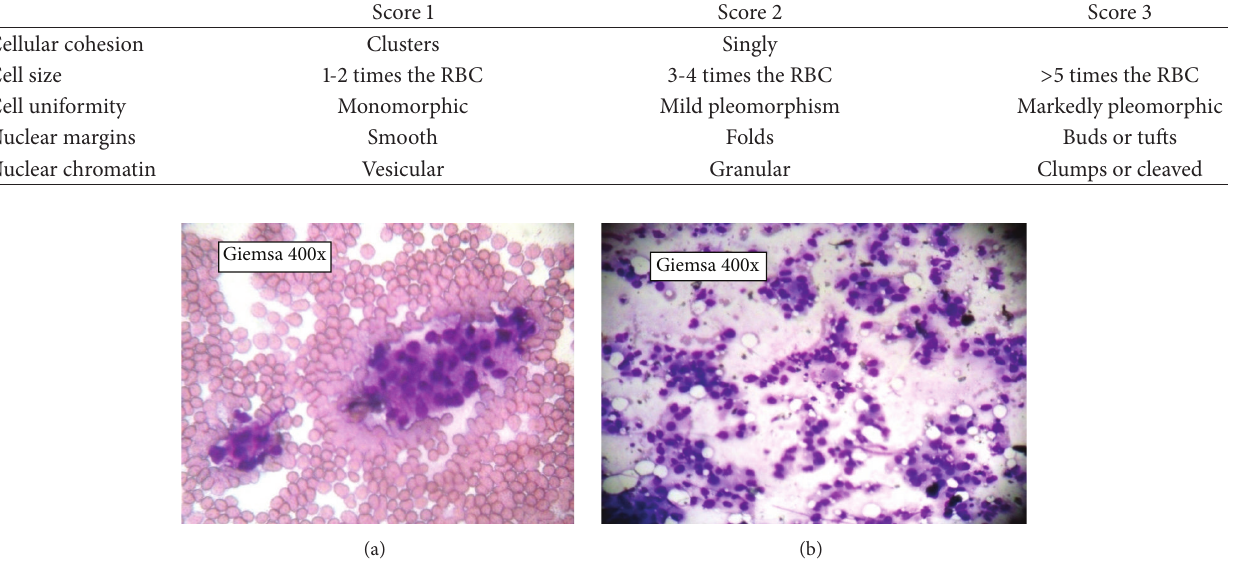
Figure 1: (a and b) Grade 1 tumor and Grade 2 tumor as per Robinson’s grading.